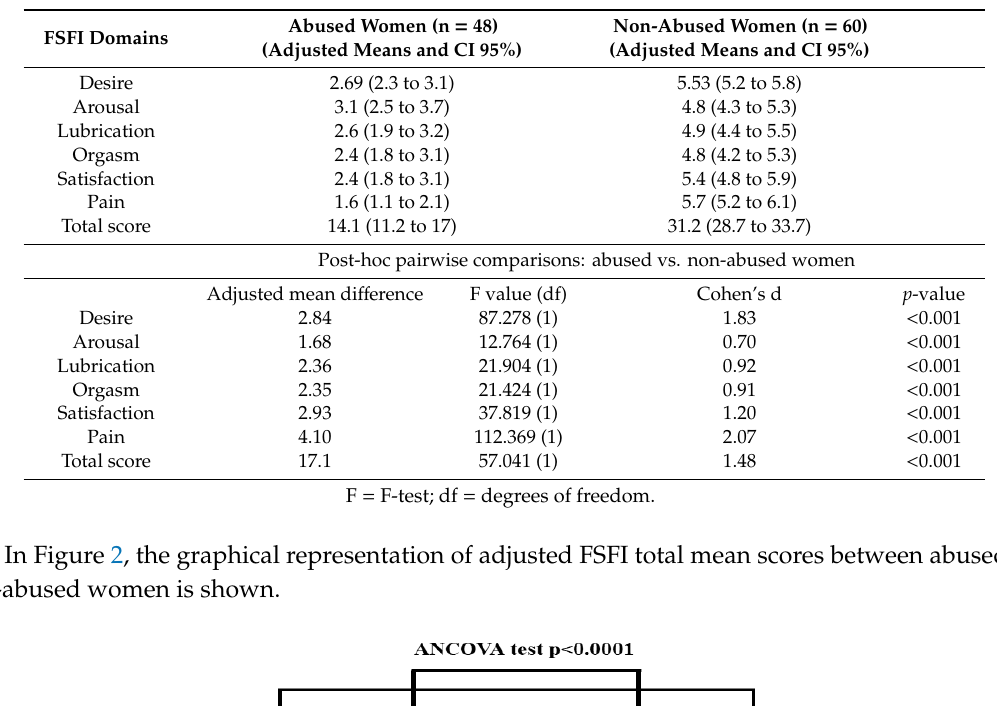
Table 3. ANCOVA analysis of Female Sexual Function Index (FSFI) sub-domains and total score with adjusted means weighted for the covariates and Cohen’s d effect size.